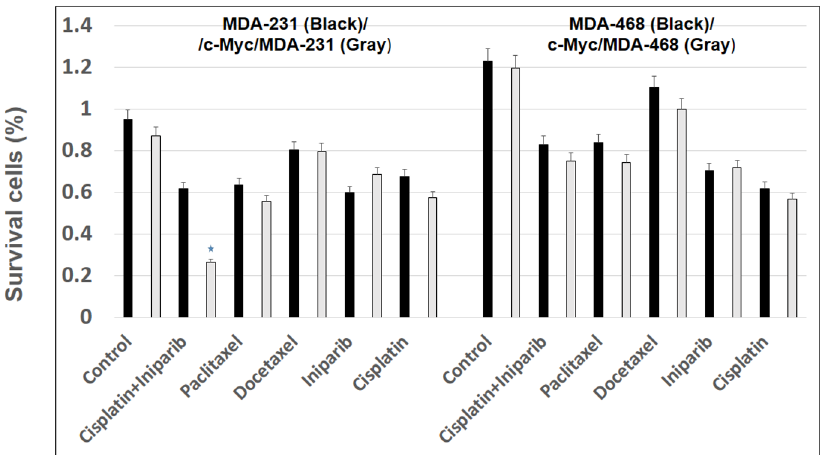
Fig 4. Myc/MDA-231 cells are sensitive to iniparib plus cisplatin treatment. The cells were treated with paclitaxel,docetaxeland iniparib(BSI-201), and iniparibplus cisplatinfor 48 h. Cell viabilitywas then analyzedby an MTT assay. Iniparibplus cisplatintreatment significantly inhibitedthe growth of c-Myc/MDA- 231 cells, in contrast they were resistant to paclitaxel,docetaxeland iniparibtreatment. Whereas, c-Myc/ MDA-468cells were resistant to all the chemotherapeutic drugs used in the treatment. Bars, mean + S.E. of triplicate determinants( * P < 0.05).